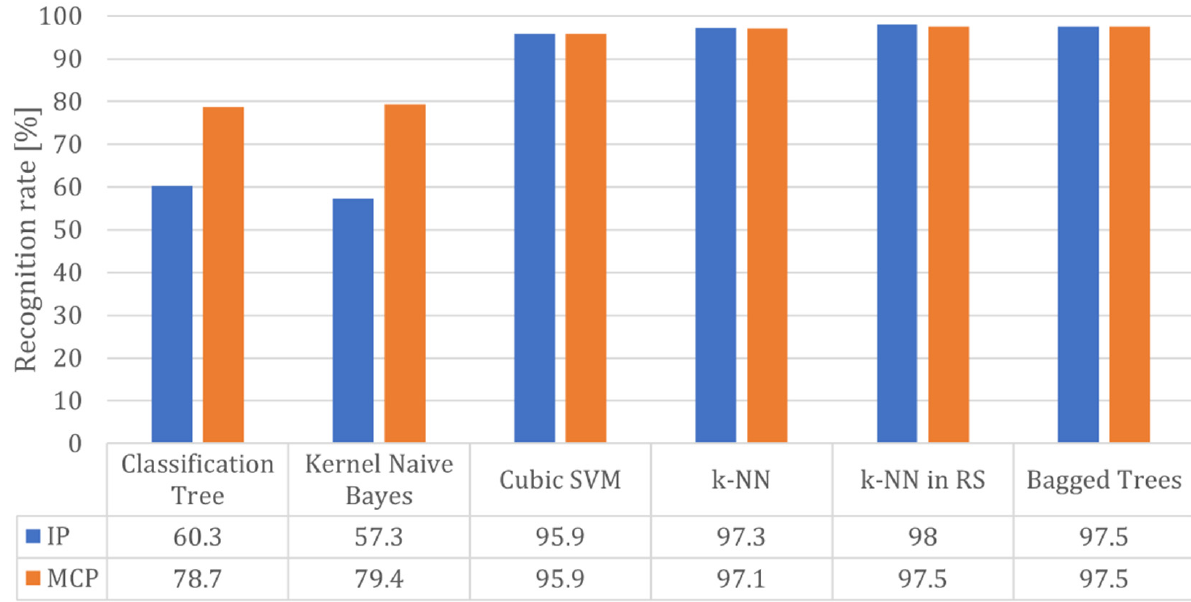
Figure 9. Classification performance as a function of the row of sensors used.